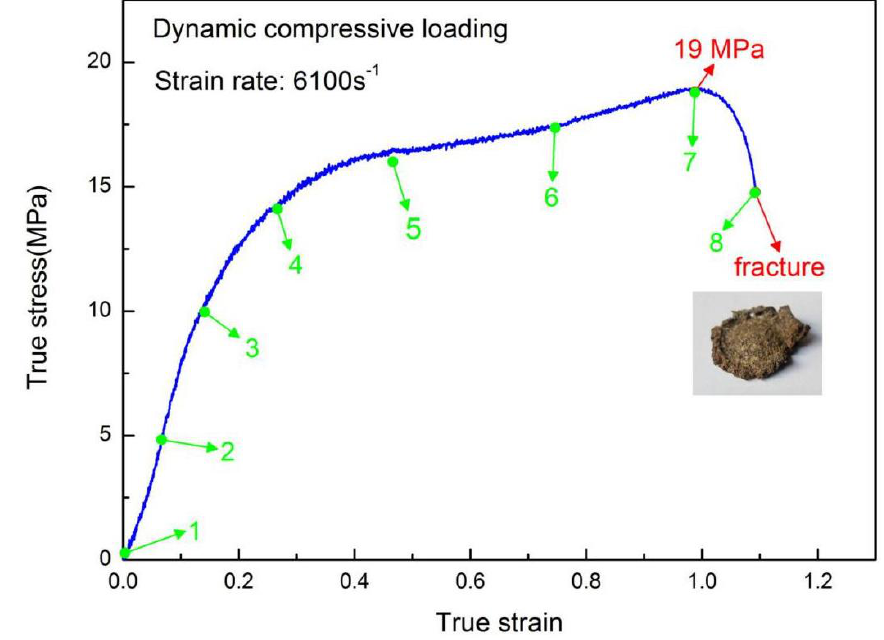
Figure 7. True stress-strain curve of H-80W under a strain rate of 6100 s − 1 , causing a final fracture, the green numbers in the curve correspond to the numbers marked in the images recorded by a high-speed digital camera in Figure 8.